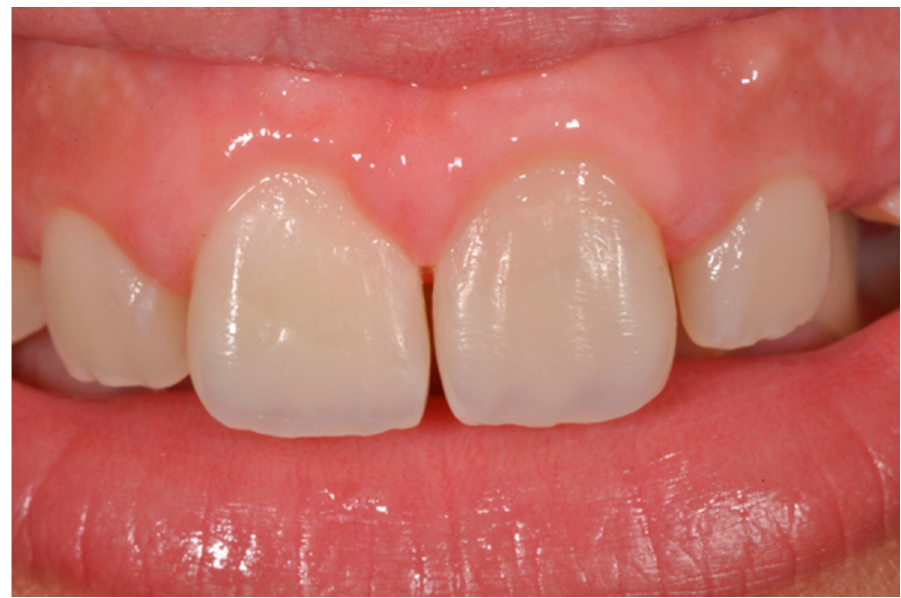
Figure 38. At 1.5 years, post-operative clinical view. Reprinted from Restauri diretti nei settori anteriori, G. Paolone, S. Scolavino, © 2021, with permission from Quintessence Publishing Italy.